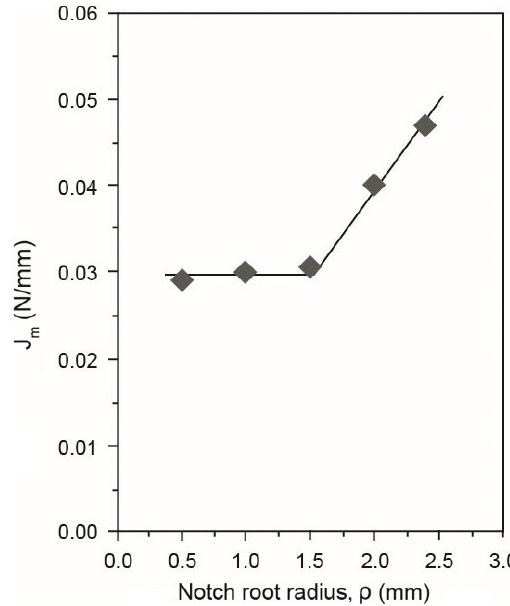
Figure 8. Variation of J with the notch root radius for the plain M mortar.